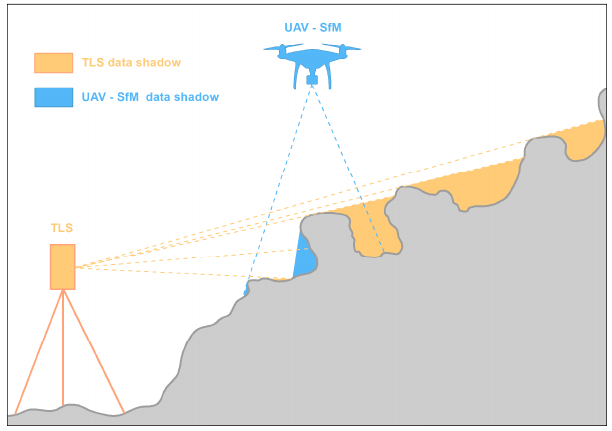
Figure 1. Viewing geometry and data coverage by terrestrial laser scanning (TLS) and unmanned aerial vehicle structure from motion (UAV-SfM) from single positions in a rugged terrain.